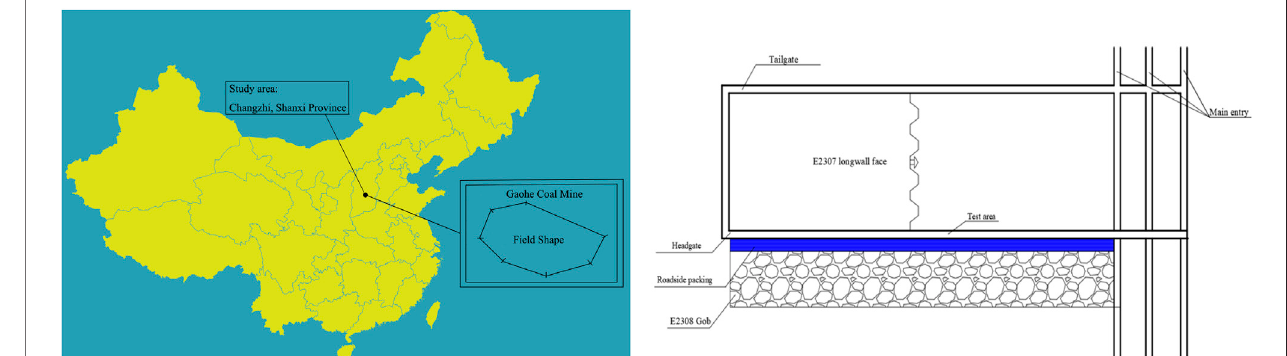
Frontiers in Earth Science |